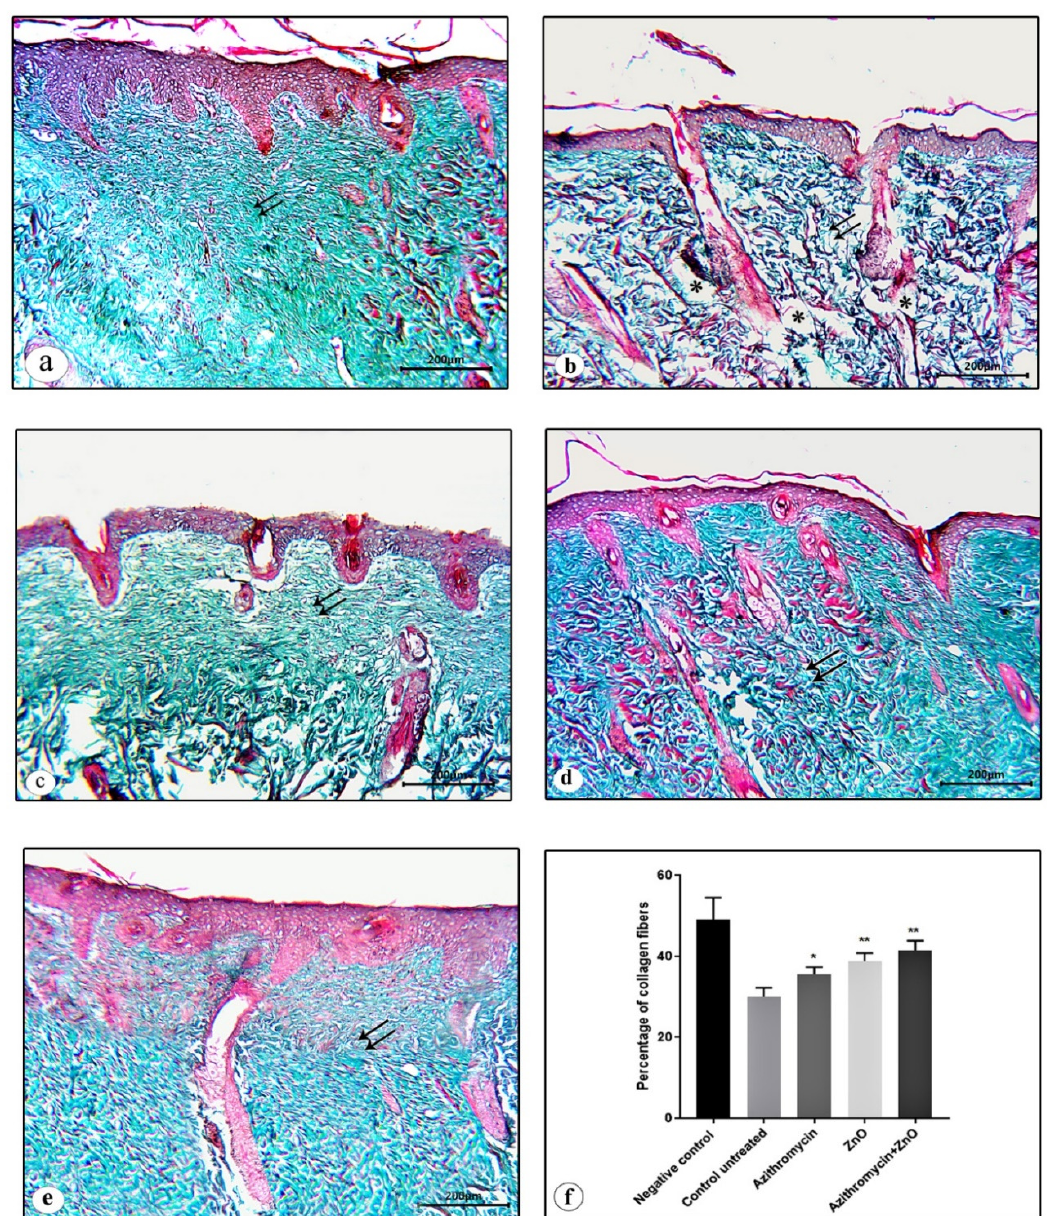
Figure 11. Masson’s trichrome-stained sections of skin from rats from all groups. ( a ) Negative control group, ( b ) untreated control group, ( c ) AZM-treated group, ( d ) zinc oxide-treated group, ( e ) AZM-ZnONP-treated group, and ( f ) mean percentage of collagen fibers of dermis in different groups. Data are expressed as mean ± SD. p -values were calculated with the Mann–Whitney test. * p value < 0.05. ** p value < 0.005. Double arrows refer to collagen fibers.